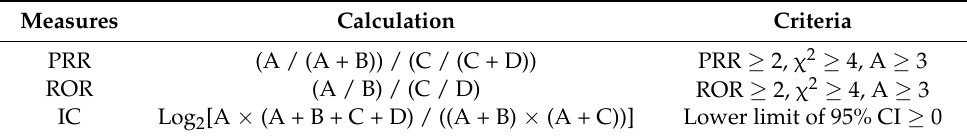
Table 6. Disproportionality analysis and signal detection